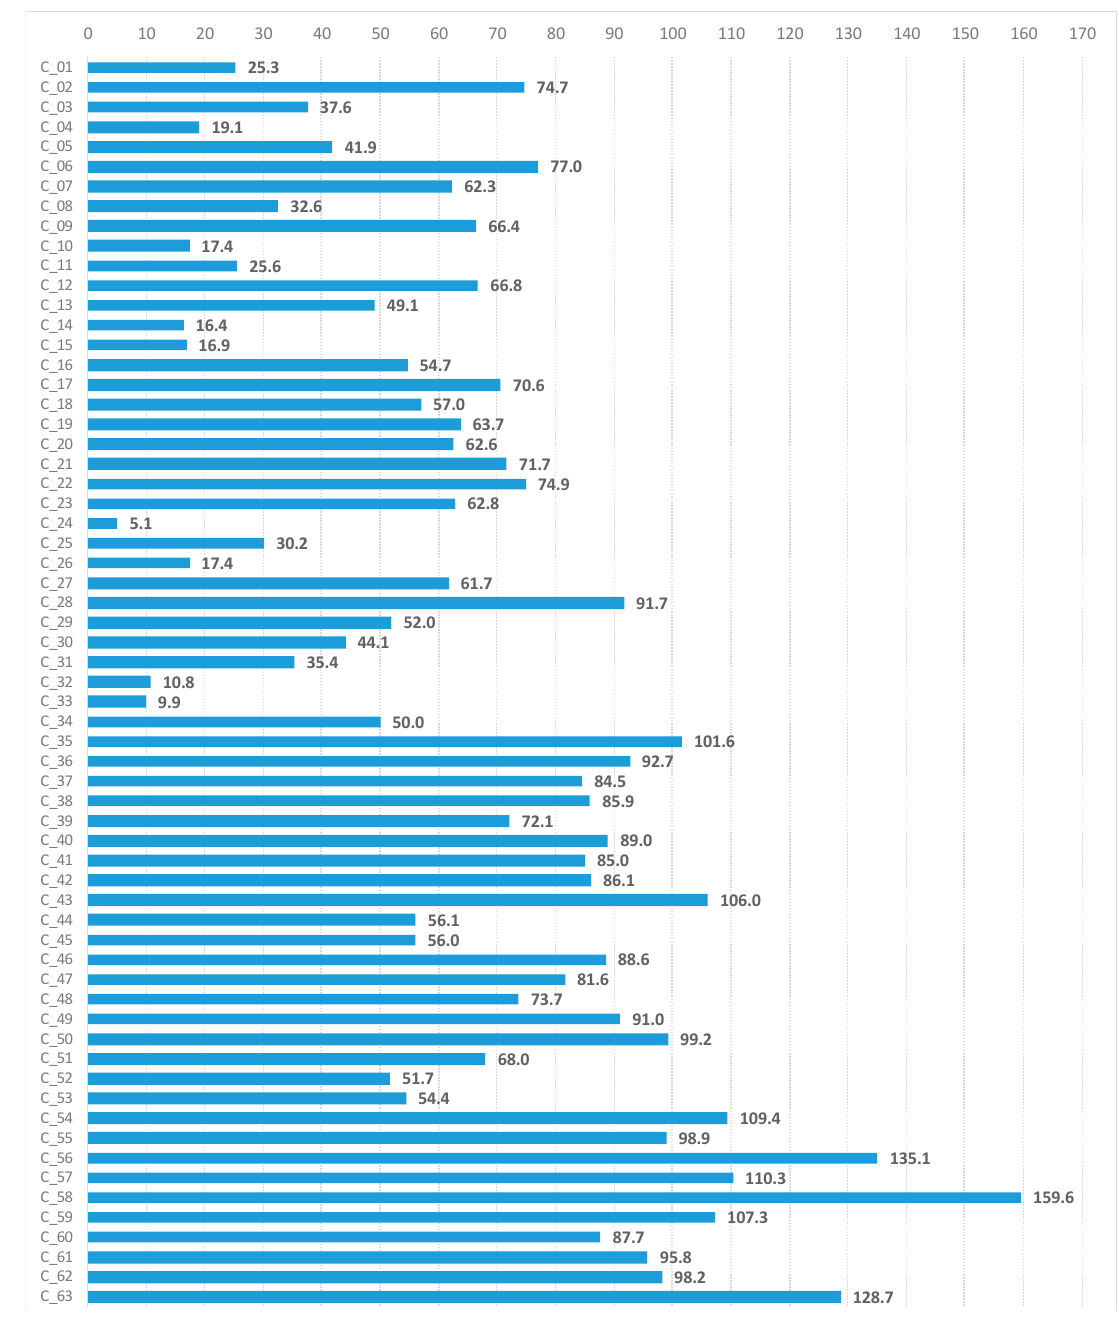
Figure 4. Average employment (jobs) reduction caused by a reduction of 1000 tonnes of GHG emissions through a reduction in demand per commodity.